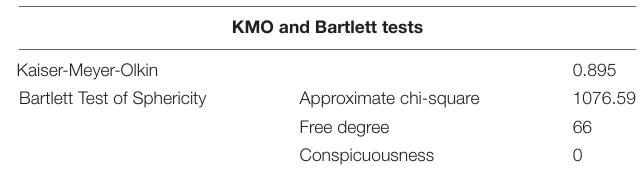
TABLE 2 | Validity